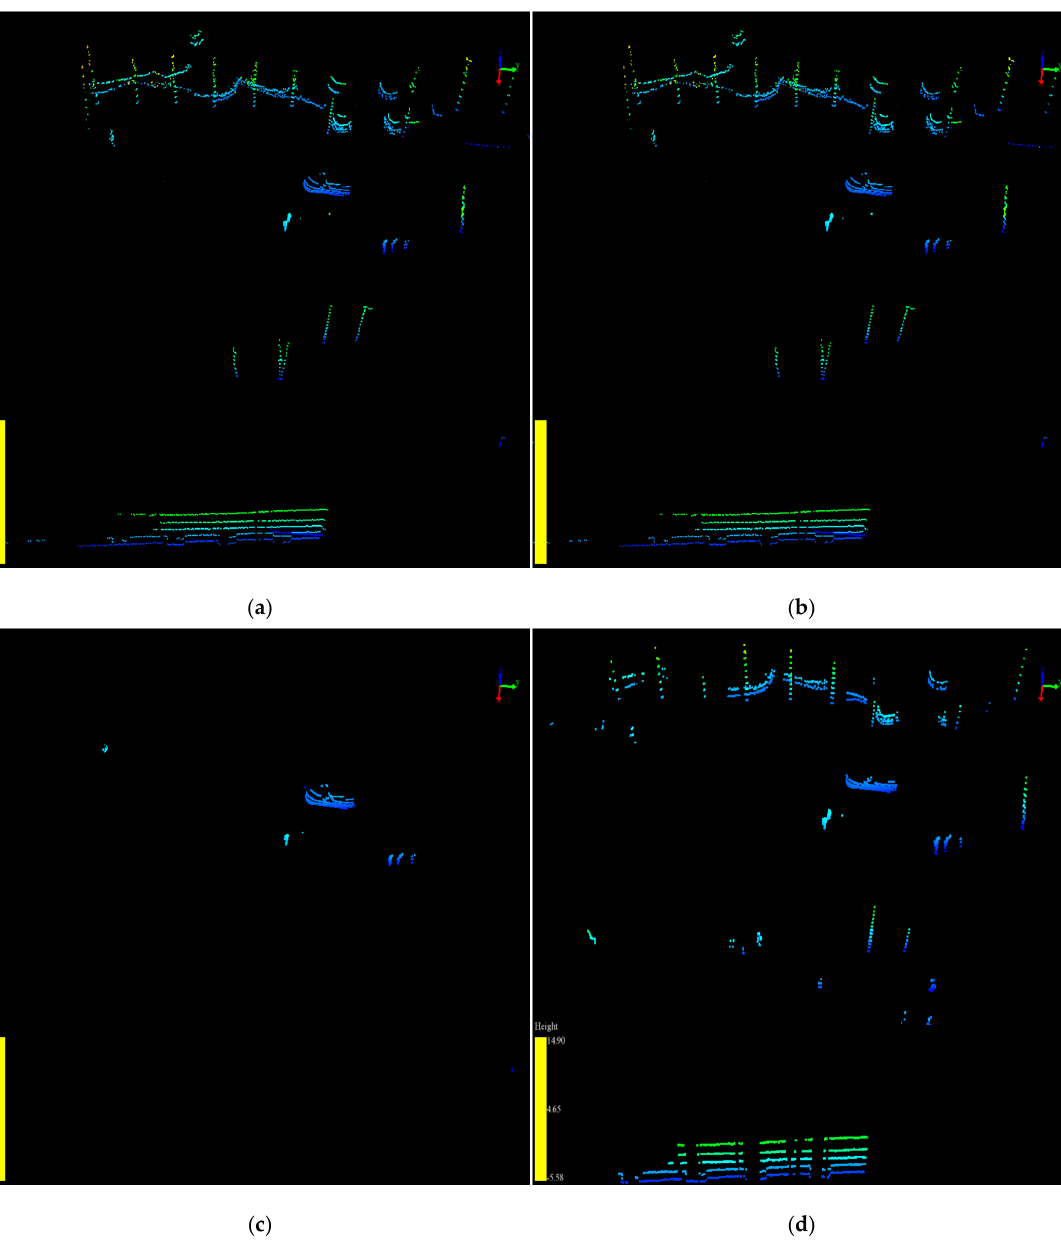
Figure 17. The VOPs before and after filtering are shown in VeloView. ( a ) The raw VOPs before filtering. ( b )The VOPs after being filtered by RANSAC; ( c ) The VOPs after being filtered by 3D-DSF; ( d ) The VOPs after being filtered by SPF.